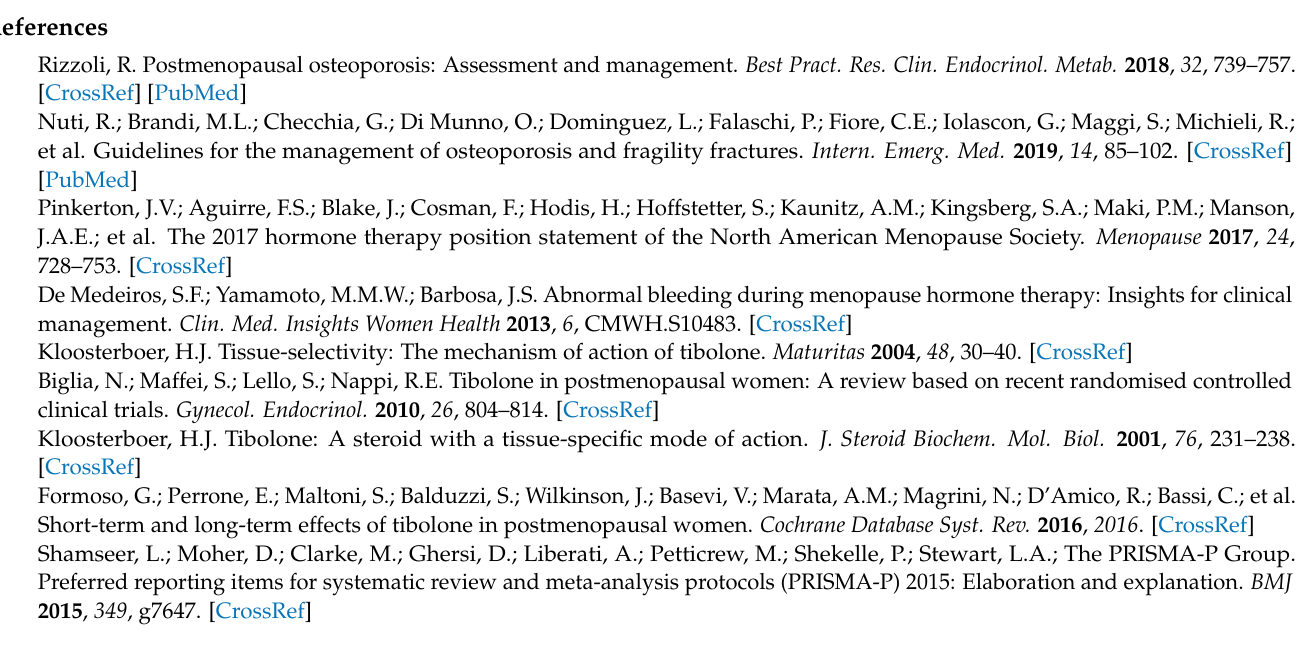
Table S3: Evidence of adverse